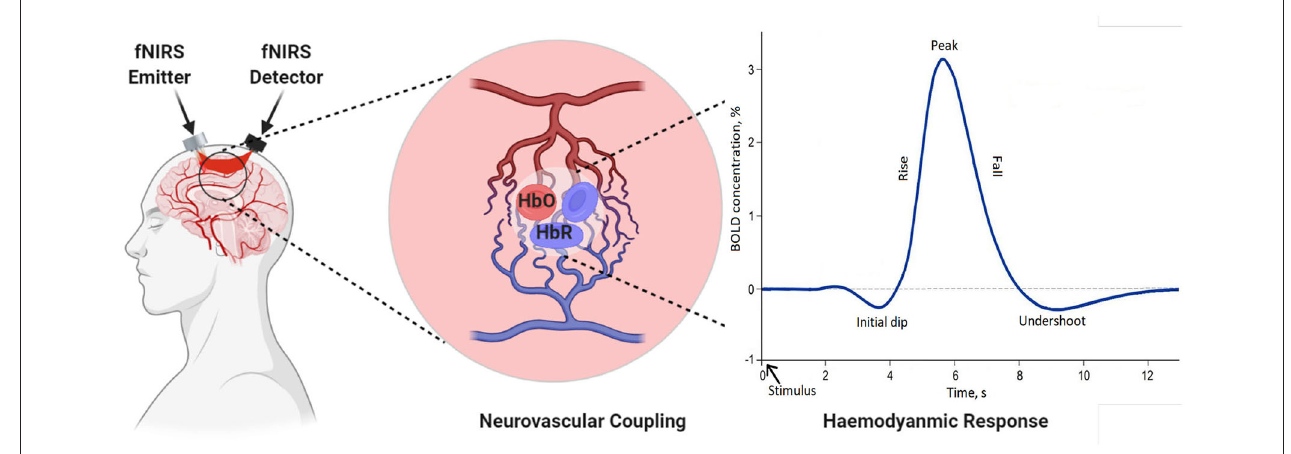
FIGURE 4 | Demonstration of neurovascular